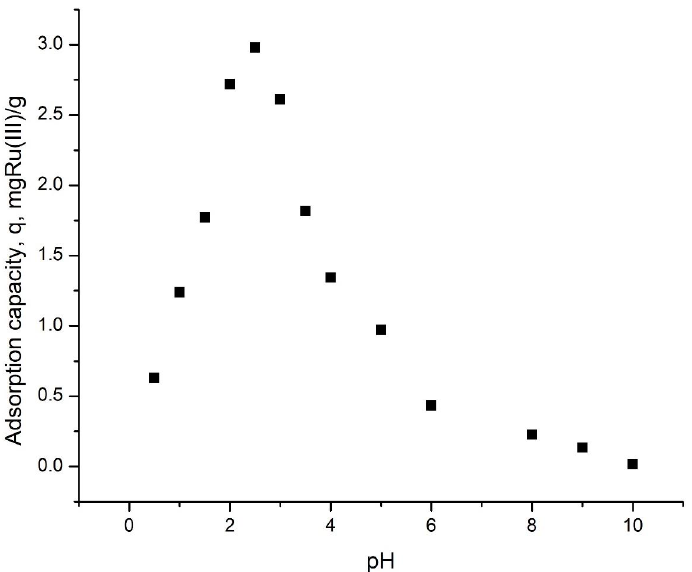
Figure 5. pH influence (data obtained for an initial concentration of 10 mg L −1 , by using 0.1 g of adsorbent material, 120 min contact time, and 298 K).